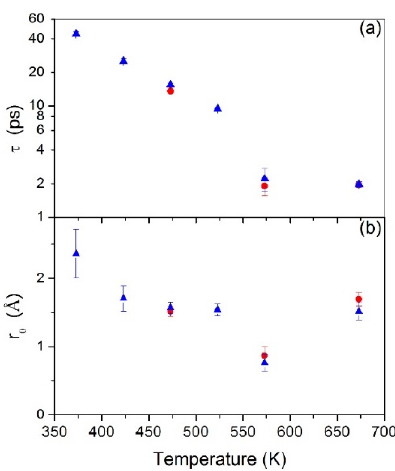
Figure 4. Residence times on a logarithmic scale ( a ) and jump length distribution ( b ), derived from the HR fit to the HWHM dependences at 2 bar (red full circles) and 4 bar (blue full triangles). For all loadings, the value at 573 K seems to deviate from the expected temperature trend.